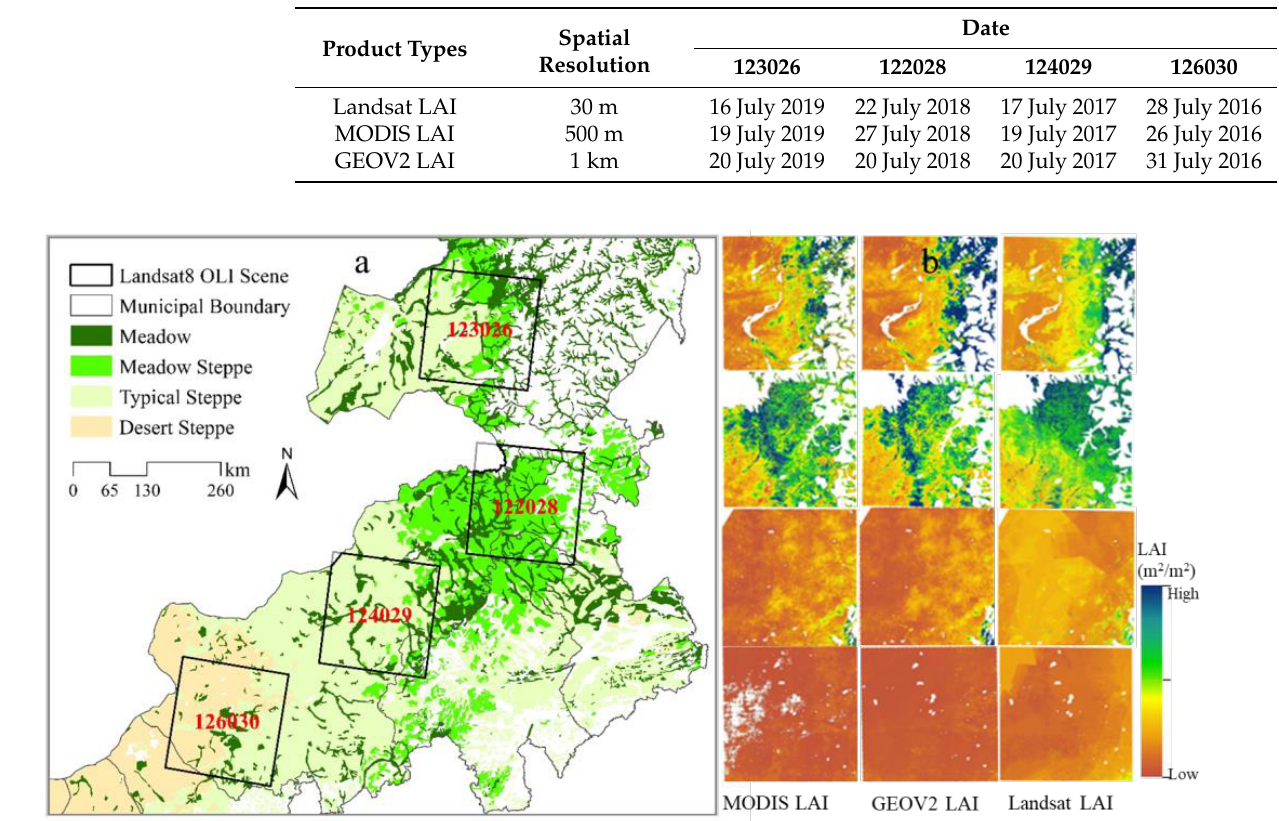
Figure 7. Location of the four selected sub-regions ( a ) and the spatial distribution of LAI in four sub-regions of the MODIS LAI, GEOV2 LAI and Landsat LAI ( b ).